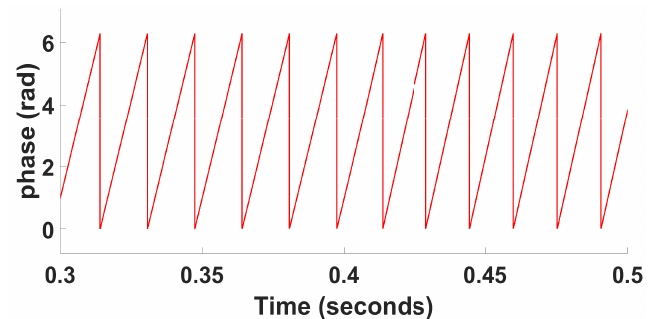
Figure 18. Balanced grid voltage with frequency change.